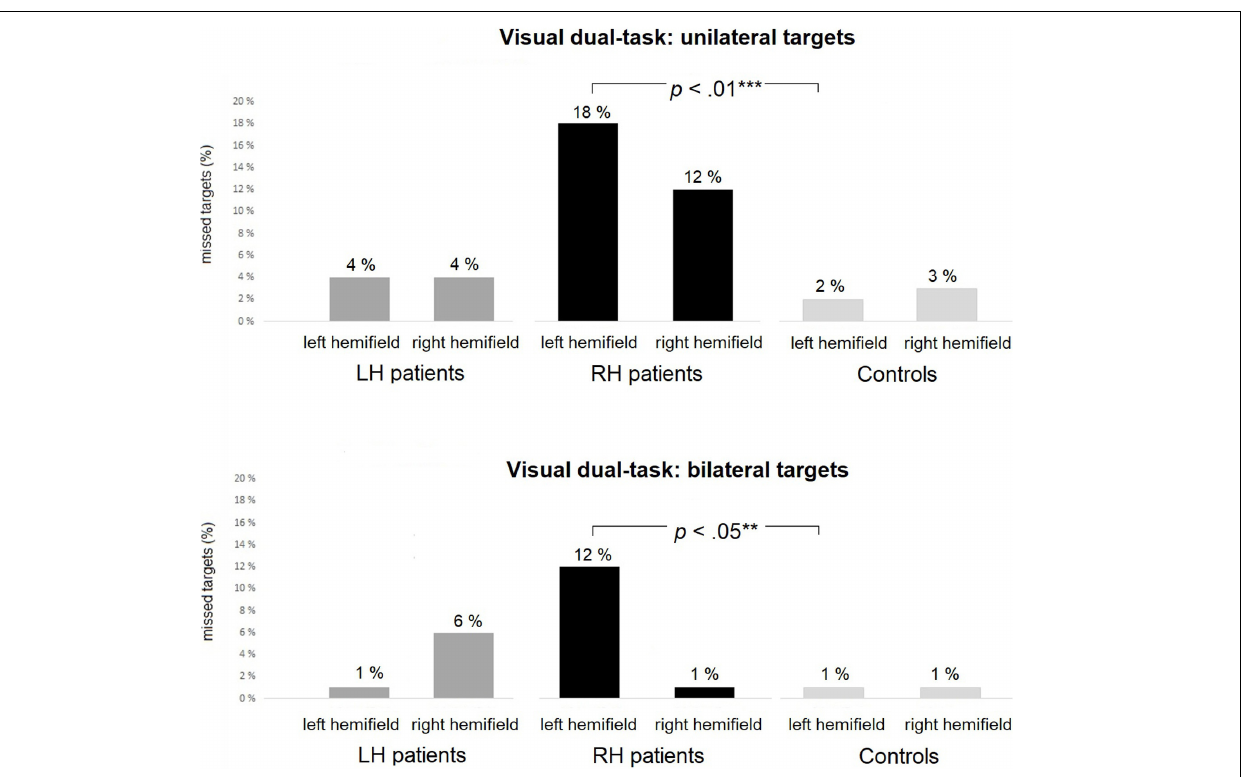
FIGURE 4 | The Visual dual-task: average percentages of missed targets within each group in unilateral (top panel) and bilateral (bottom panel) trials. RH patients missed significantly more left-sided targets than controls in both the unilateral and bilateral trials. Asterisks represent effect size (***large effect; **medium effect).